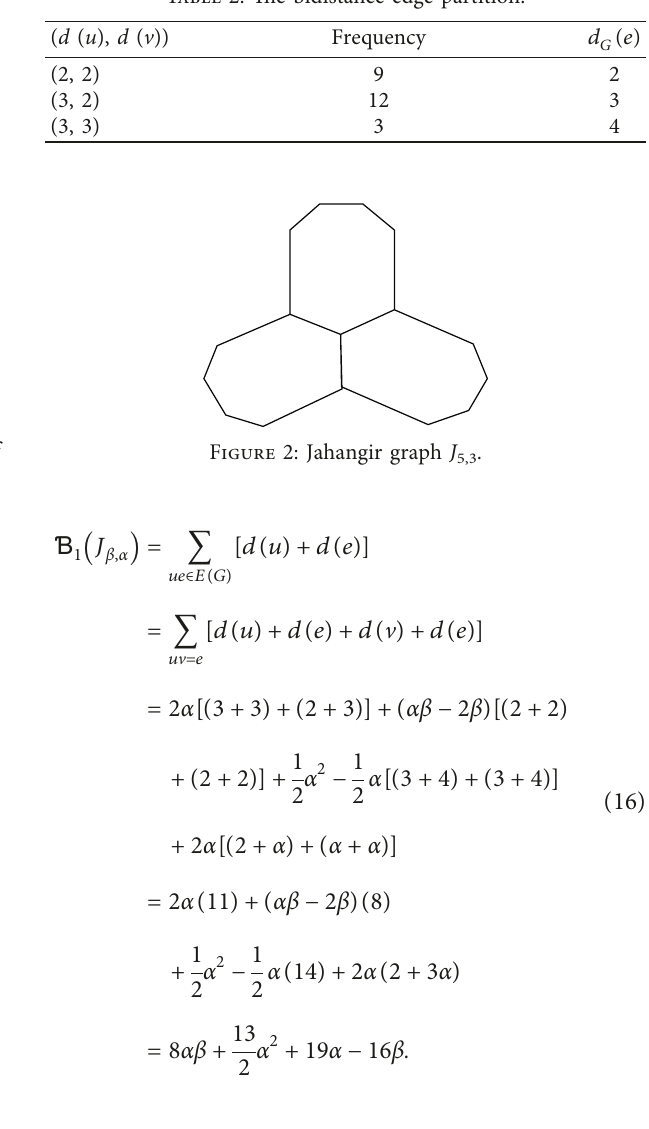
Table 2: The bidistance edge partition.